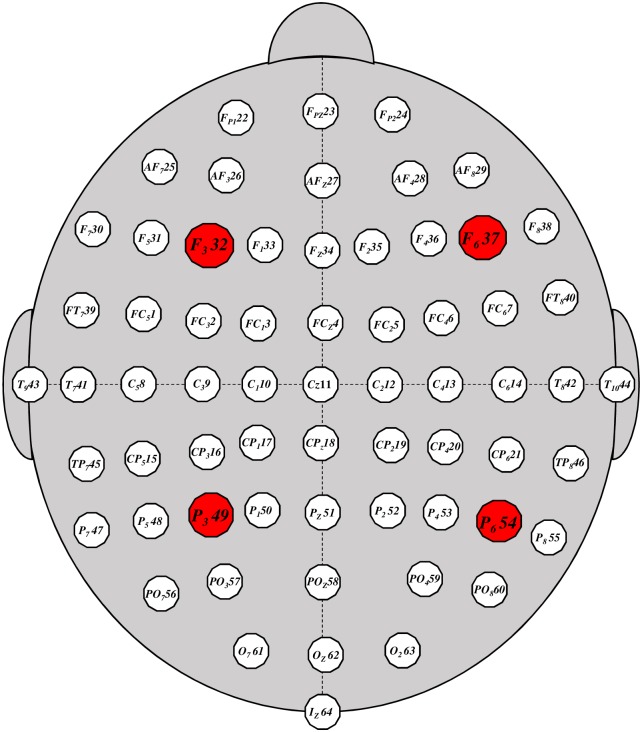
(Color on-line) Setup for EEG channels: 64 electrodes as per the international 10-20 system (excluding electrodes Nz, F9, F10, FT9, FT10, A1, A2, TP9, TP10, P9, and P10).The specific points (full circle in red) (F332, F637, P349, P654) identify the channels used in this paper.